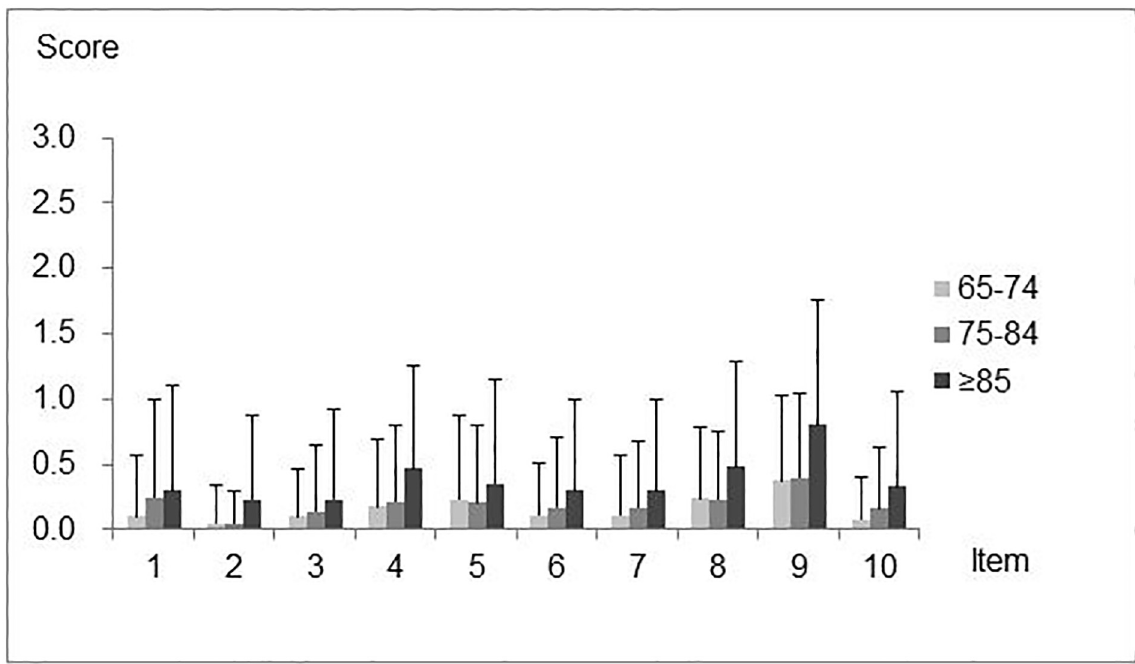
Fig 1. Mean Eating Assessment Tool (EAT-10) scores for each item in independent older people. Values are expressed as Mean and standard deviation (SD).